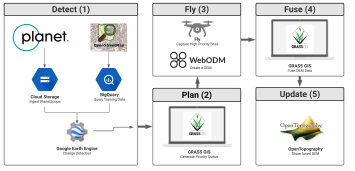
Figure 1. Rapid-DEM is a five-phase process that detects, plans, flies, fuses, and updates urban topographic change. Phase (1) generates land cover maps used to identify land cover change. Phase (2) creates a priority queue that identifies the most important change. Phase (3) uses the data from the priority queue to fly high priority locations and generate updated elevation models. Phase (4) fuses UAS-based DEM with an existing DEM dataset and phase (5) shares the updated fused DEM with the broader